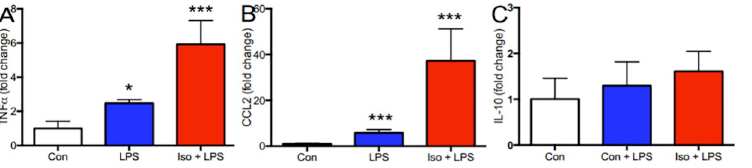
Fig 6. Isoflurane amplifies the hippocampal neuroinflammatory response to LPS in old mice. 20 month old mice were anesthetized as described and 1 h later received an intraperitoneal injection of LPS (500 ug/kg). Control mice received 30% oxygen plus an equal volume of saline i.p. or LPS. Anesthesia continued for 3 h (4 h total) to mimic ongoing surgery under general anesthesia; controls received 30% oxygen for the same period. Mice were sacrificed 3 h after emergence and TNF α , CCL2 1, and IL10 expression measured in the hippocampus by RT-PCR. As expected, LPS alone increased TNF (~3-fold) and CCL2 (~6-fold). This response was markedly exaggerated in old mice that received anesthesia, with TNF increasing ~6-fold and CCL2 up ~37-fold. Levels of IL-10 were slightly and non-significantly increased after LPS and LPS irrespective of isoflurane exposure (C). Note differences in the y-axis scale. Data expressed as mean ± SD for N = 5–6 animals per treatment condition. � p < 0.05, ��� p < 0.001 by 1-way ANOVA with Dunnett’s test for multiple comparisons.